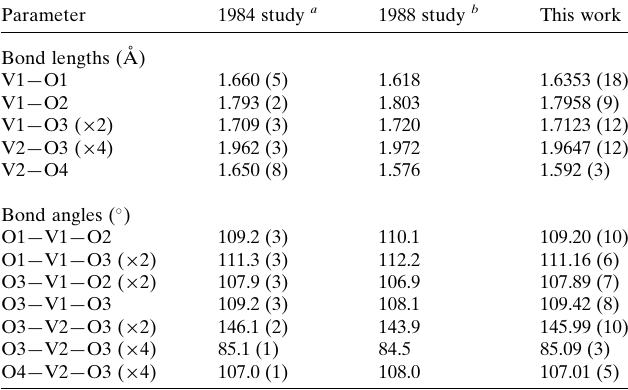
Table 1 Bond lengths (A˚ ) and angles ( (cid:6) ) in (NH 4 ) 2 V 3 O 8 for vanadium sites determined in this work, compared to those reported in previous